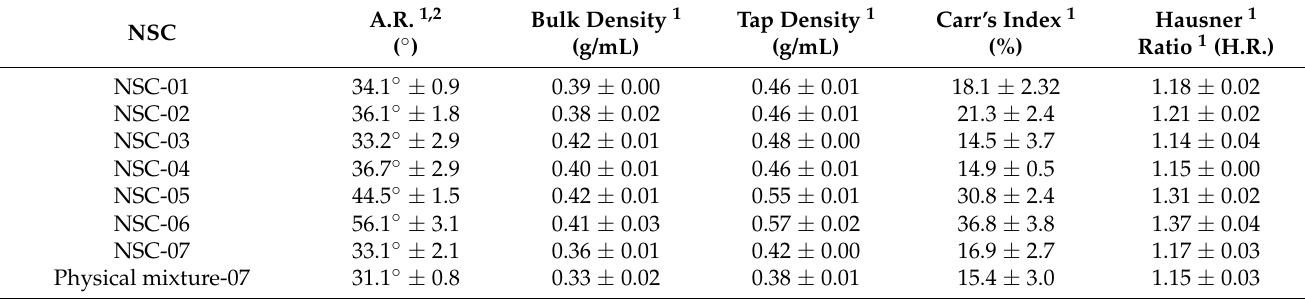
Table 3. Flowability of Neu-based